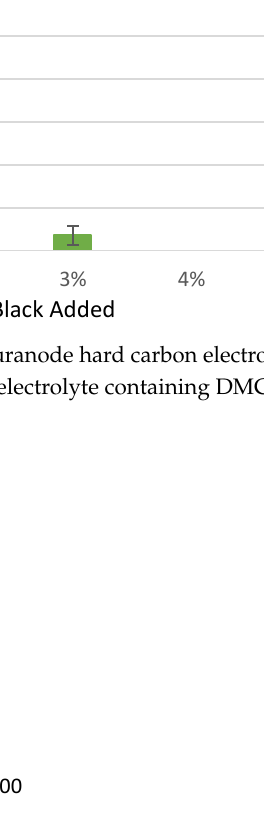
Figure A3. Nyquist plot showing the impedance spectra of the Kuranode hard carbon electrodes with different conductive additive contents, as measured with the electrolyte containing DMC as a low-viscosity solvent.